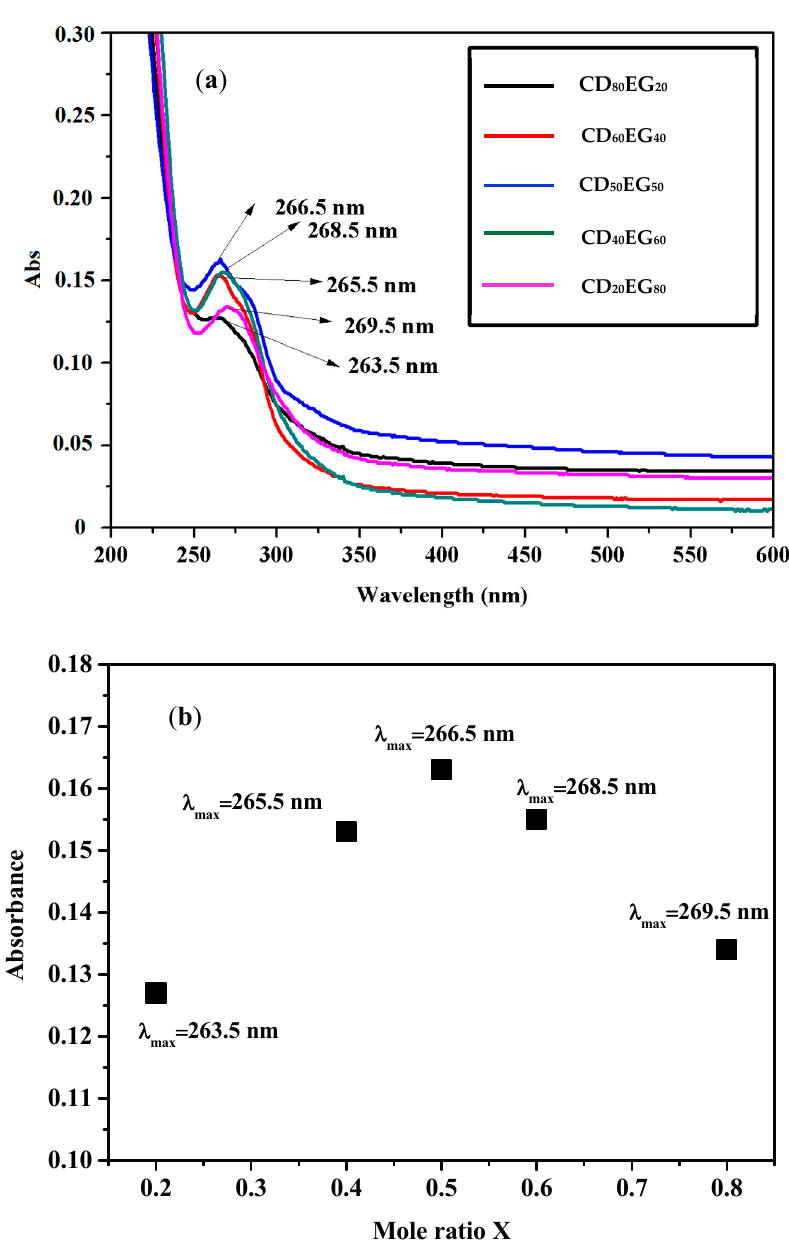
Figure 1. ( a ) UV–Vis spectra of CD-EG complexes at various concentrations at wavelength 200–600 nm; ( b ) Plots of the CD-EG inclusion complex where the mole ratio X = [EG]/([EG] + [CD]) at total concentration [EG] + [CD ] = 100 µM. The y-axis corresponds to the absorbance of the shifting peak of CD-EG compared to initial absorbance of un-reacted EG (274 nm) at 25 °C.